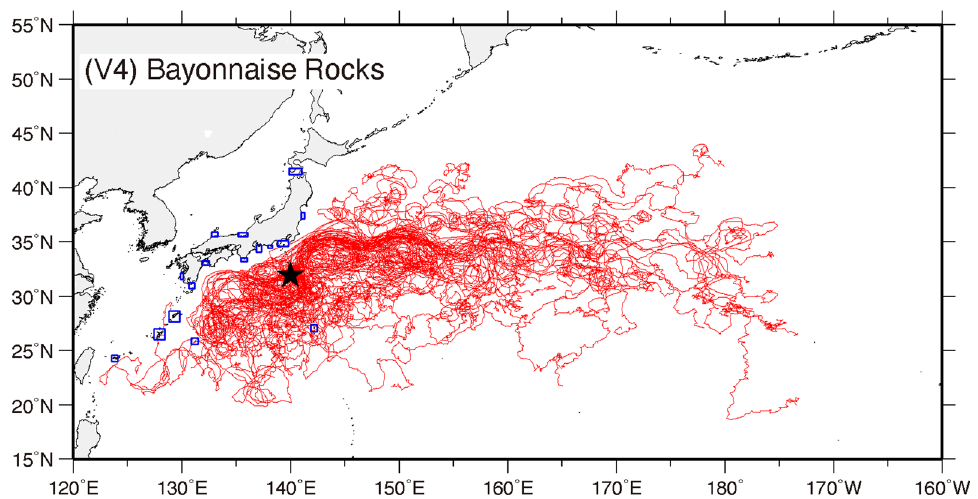
Fig. 11 Simulated drift paths of 50 randomly selected virtual pumice clasts released from (V4) Bayonnaise Rocks (black star) on 15 March 2004. Blue rectangles indicate target areas